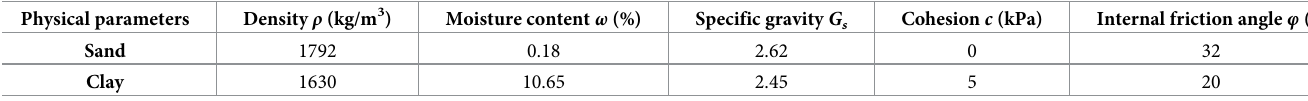
Table 2. Basic physical parameters of sand and